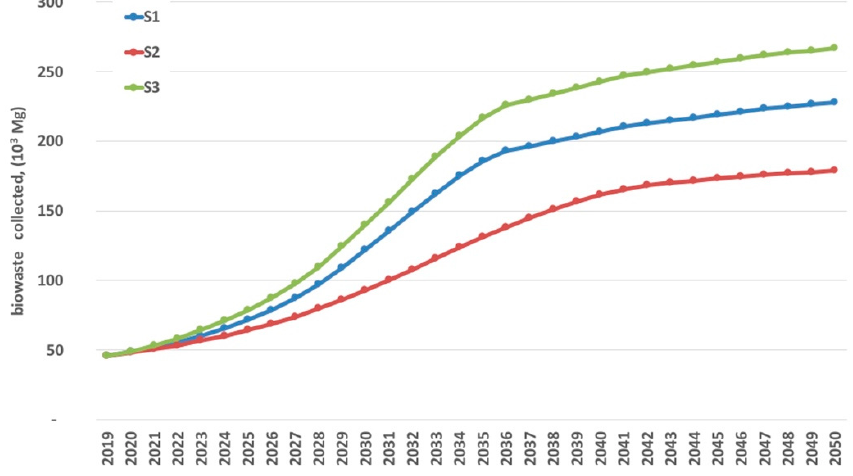
Figure 5. Biowaste separate collection scenarios.